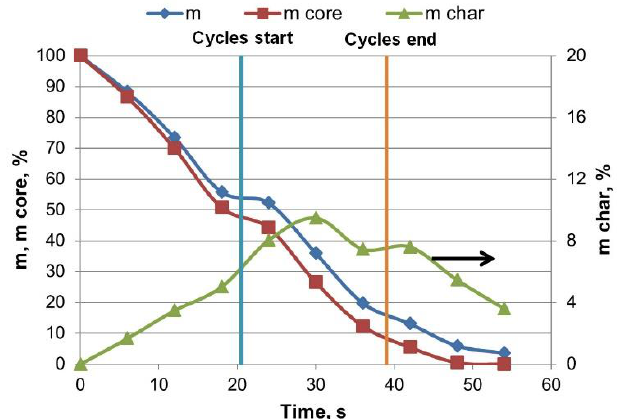
Figure 8. Change in the relative mass of the sample, its wood core and char layer over time (T furnace—800 °C, air velocity—20 m s −1 , burning takes place in the furnace space). The vertical lines indicate the beginning and end of the cyclic movement of the flame.